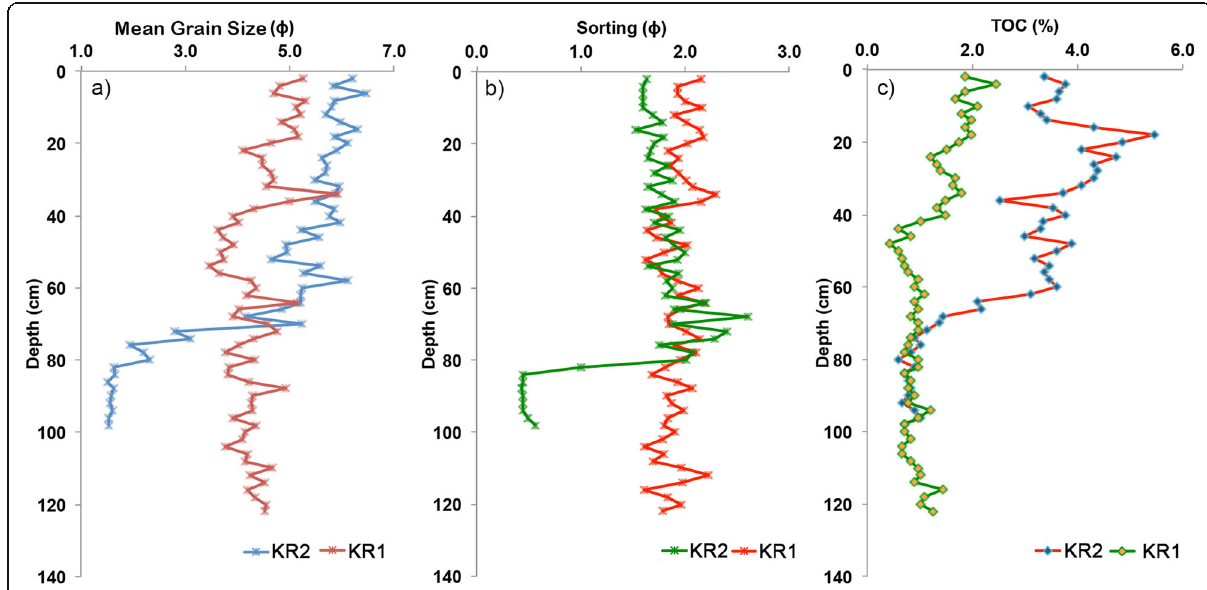
Fig. 2 Vertical profile of ( a ) mean grain size, ( b ) sorting, and ( c ) TOC